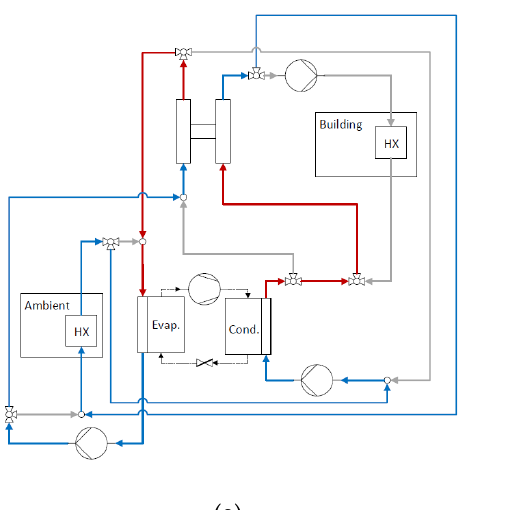
Figure 1. Heat and mass exchanger (HMX) with absorber / desorber on the left side and evaporator / condenser on the right side being connected to each other for water vapor exchange. During charging, diluted sorbent enters the desorber from the top leaving it as concentrated sorbent at the bottom. Thereby, water is evaporated by the external heat source and transported to the condenser, where it changes back to its liquid state, releasing heat to a respective sink. In charging, concentrated sorbent enters the absorber at the top, leaving it as diluted sorbent at the bottom. Thereby, water being evaporated by a low temperature heat source in the evaporator is absorbed, releasing useful heat for space heating or domestic water production. Heat exchange between sorbent and heat transfer fluid is followed in counterflow, allowing for the optimal exploitation of available temperatures. Adapted from [20].